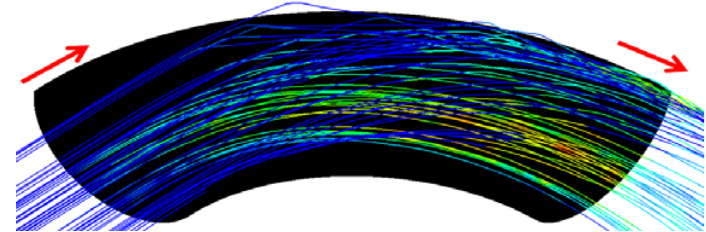
Figure 15. Particle trajectories at 2 m/s flow speed in the bottom half elbow section.